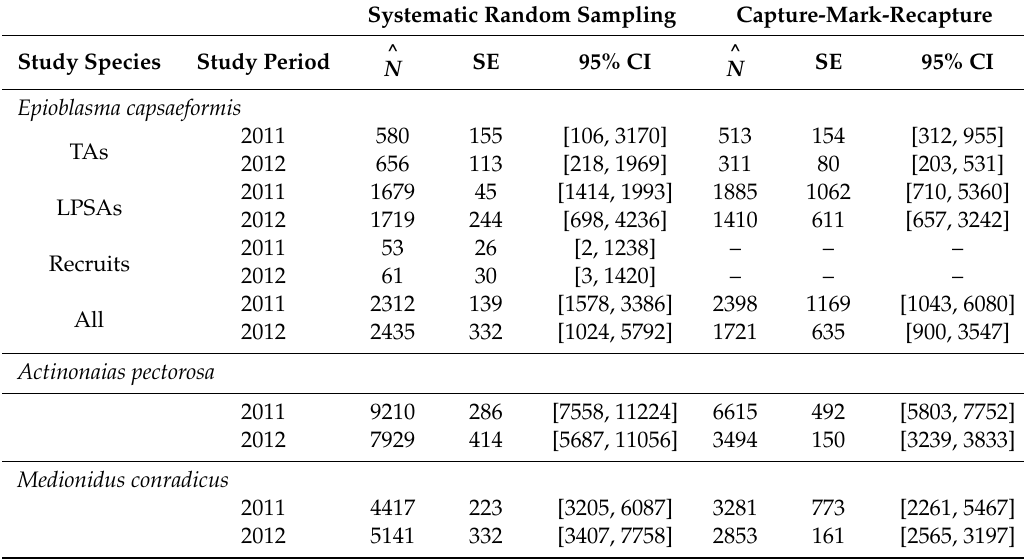
Table 3. Abundance estimates for Epioblasma capsaeformis (TAs = translocated adults, LPSAs = laboratory-propagated subadults), Actinonaias pectorosa , and Medionidus conradicus at Cleveland Islands in the Upper Clinch River, Russel County, Virginia from systematic random quadrat and capture-mark-recapture sampling in 2011 and